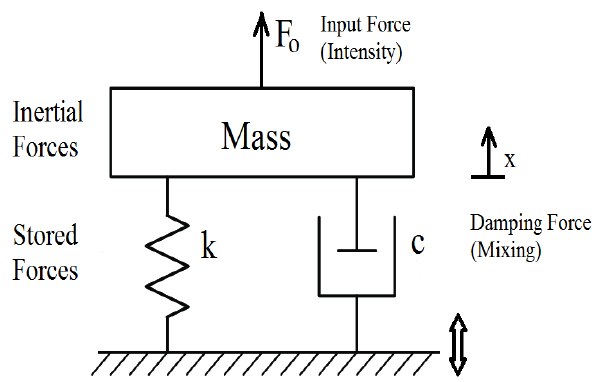
Figure 1. Schematic diagram of the RAM System (Simple Mass-Spring-Damper System).